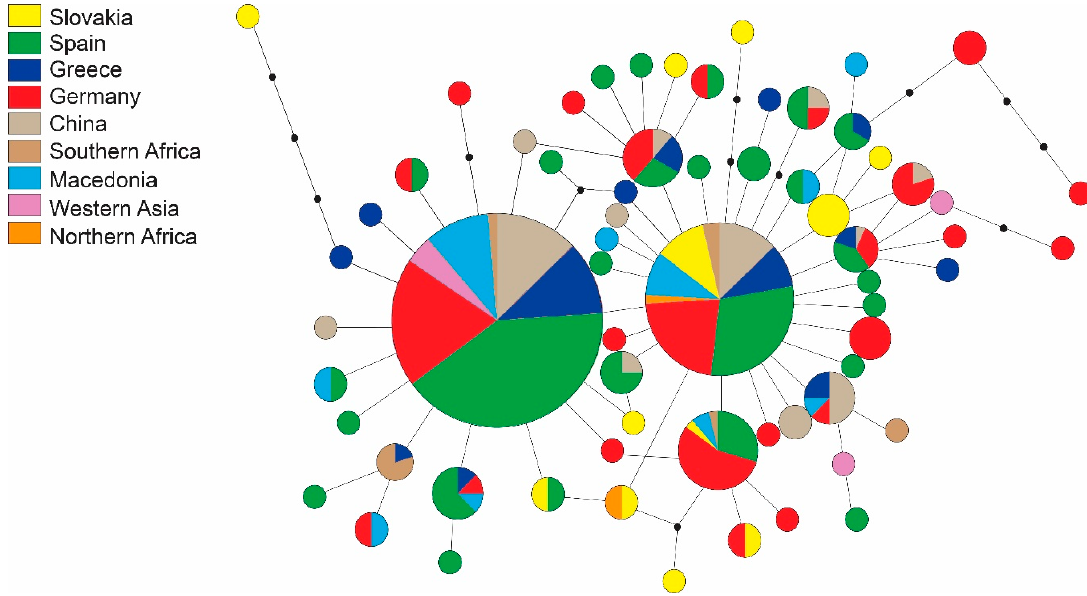
Figure 1. Haplotype network of Merops apiaster using statistical parsimony based on the cytochrome b gene. Colors correspond to the specific origins. Table 1. Genetic diversity and demographic population parameters based on the cytochrome b gene of di ff erent populations of Merops apiaster. * p <